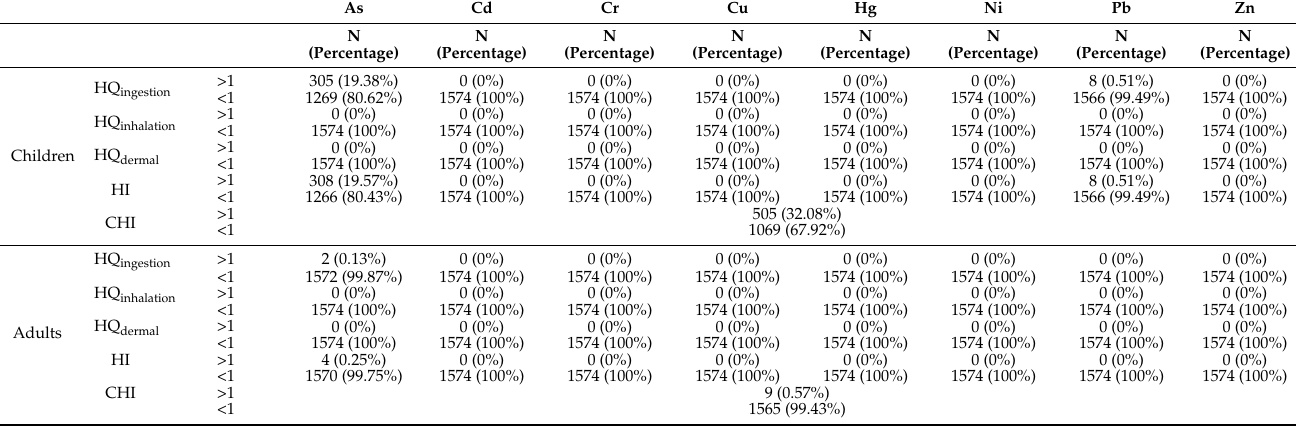
Table 7. The number of sites (percentage) of non-carcinogenic risk levels to humans from soil PTEs.